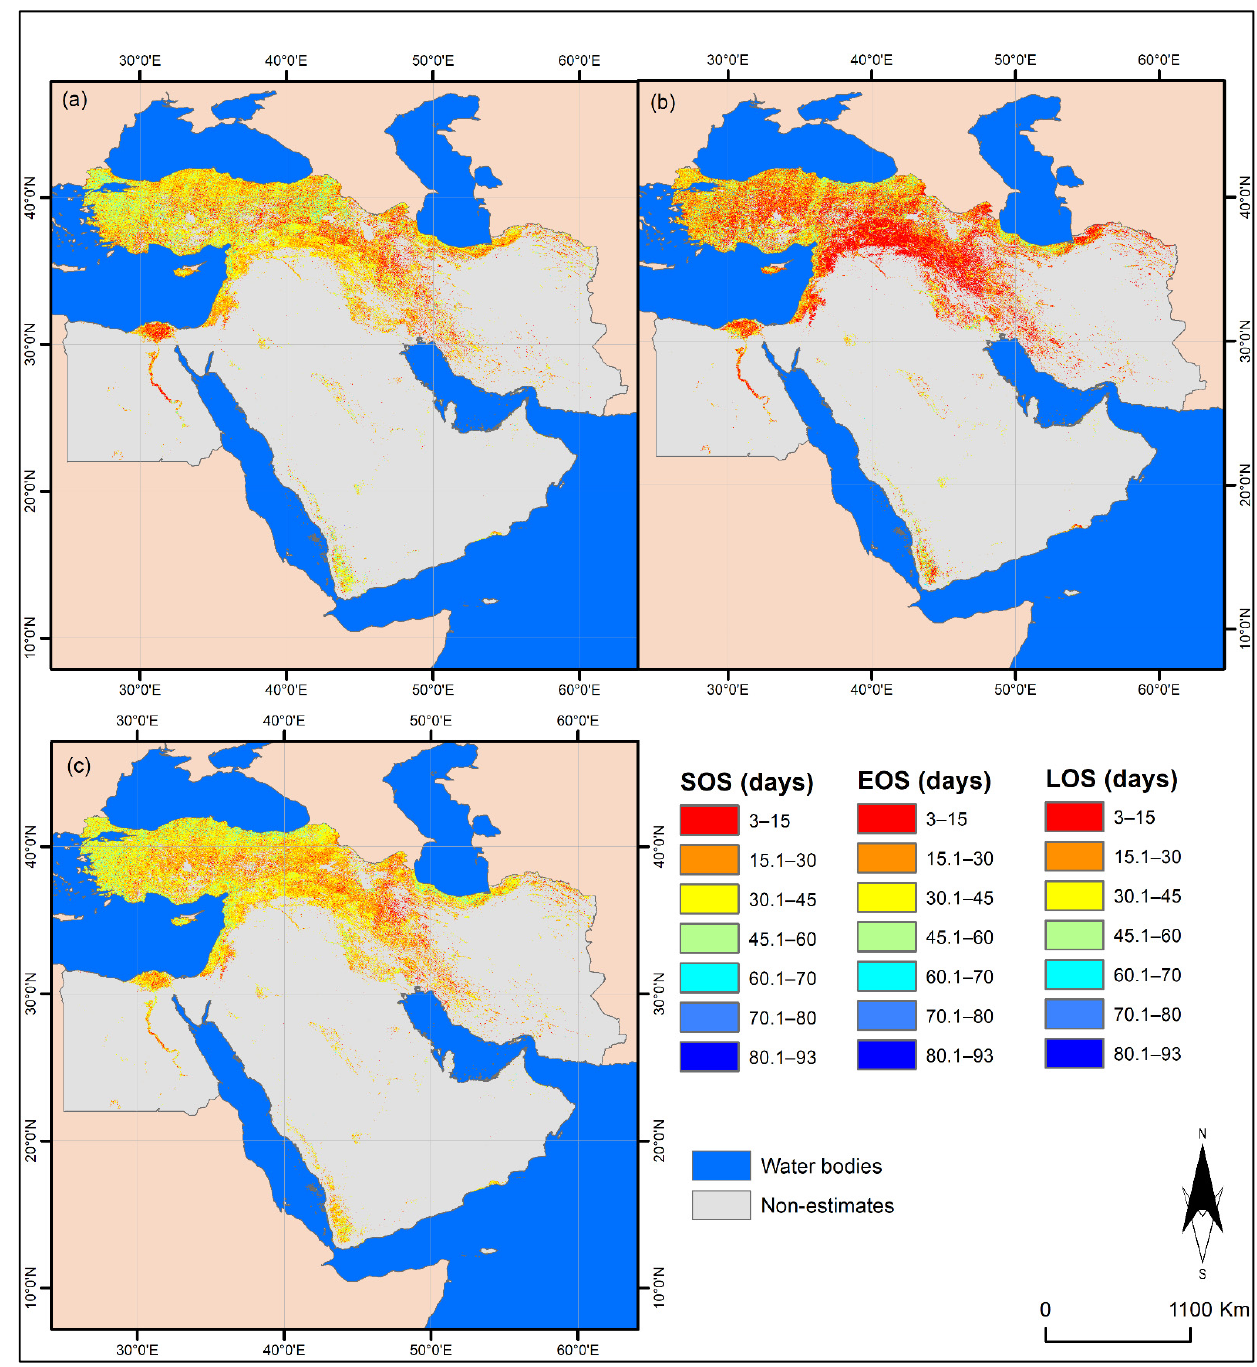
Figure 5. The standard deviation of LSP parameters ( a ) SOS, ( b ) EOS, and ( c ) LOS, in a number of days for the period of 2000–2020.